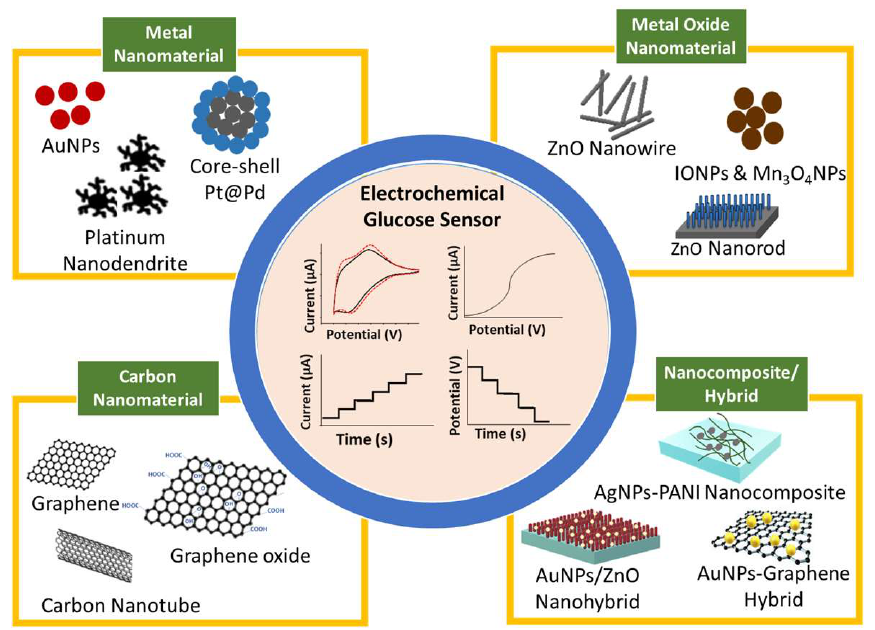
Figure 1. Schematic of nanomaterial-modified electrode for glucose biosensor.